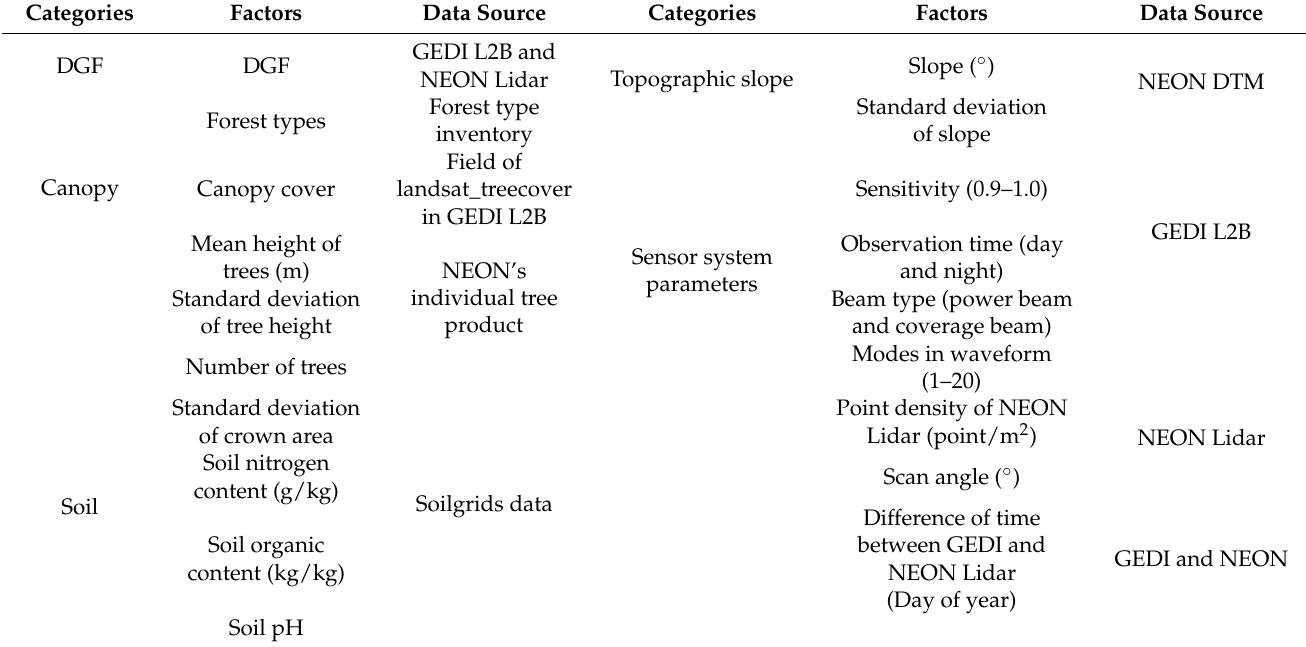
Table 1. Definition and data sources of factors potentially affecting the absolute deviation of GEDI LAIe used in factor importance